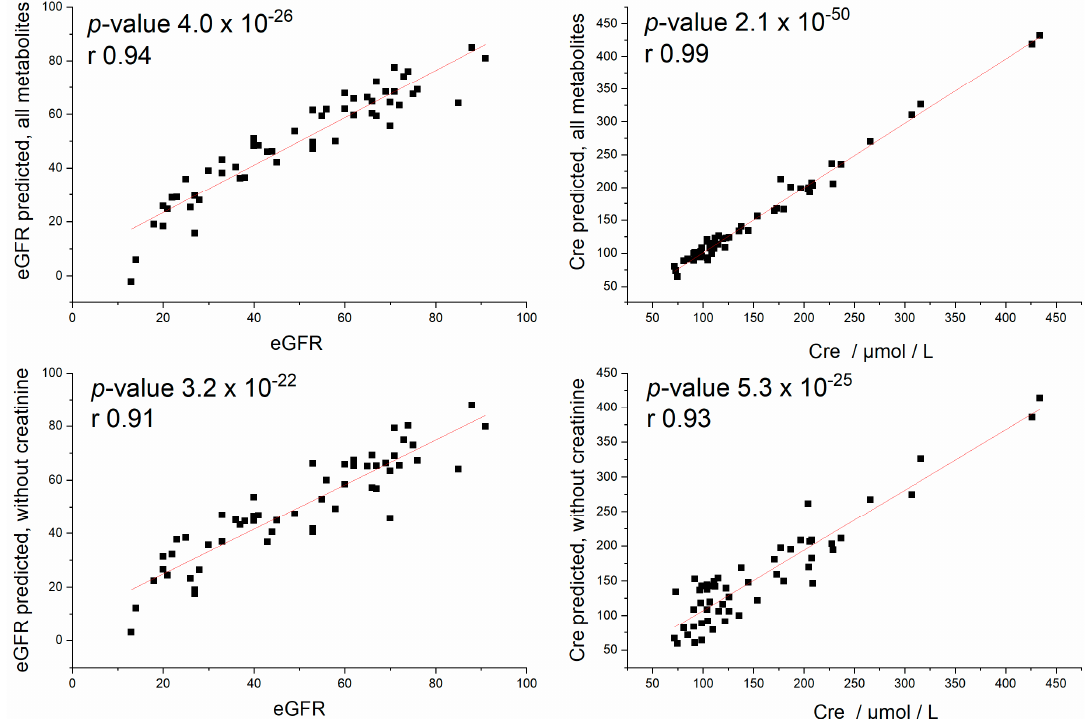
Figure 5. Results from Pearson’s correlation following multilinear regression analysis, where relative plasma concentrations were used as independent variables; predicted vs. measured eGFR (with creatinine: p -value = 4.0 × 10 − 26 and r = 0.94, without creatinine: p -value = 3.2 × 10 − 22 and r = 0.91) and predicted vs. measured Cre plasma level (with creatinine: p -value 2.1 × 10 − 50 and r = 0.99, and without creatinine: p -value = 5.3 × 10 − 25 , r = 0.93).